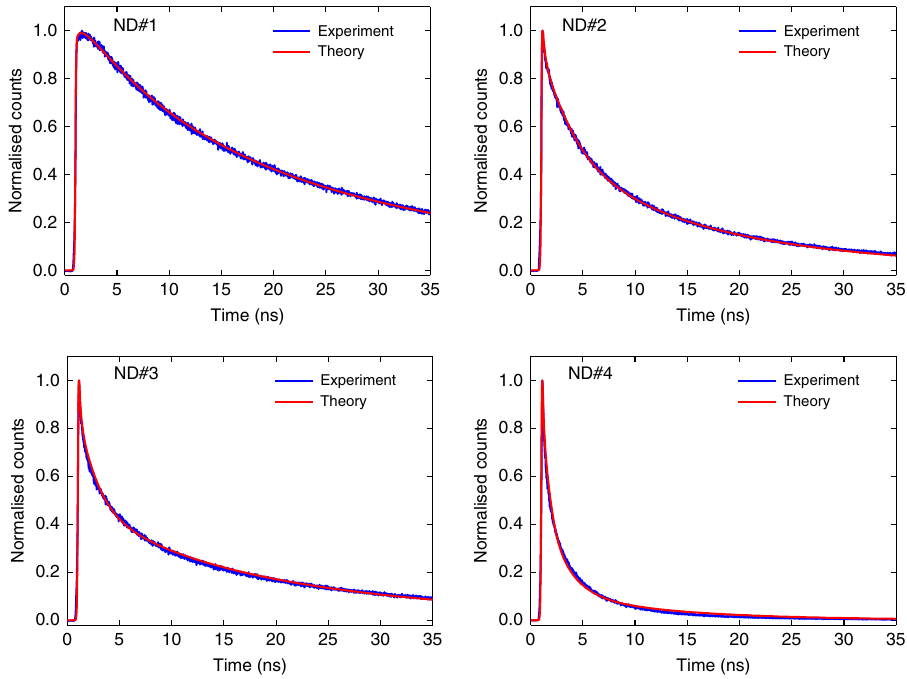
Fig. 2 Fluorescence decay curves and corresponding fi ts for four different NDs. The four graphs display measured fl uorescence decay curves (blue) with corresponding fi ts (red) obtained from our model (see main text), showing excellent agreement. Note that the curves are normalised to their respective maximum. The different NDs exhibit increasingly faster photo-emission, with corresponding lifetimes of {25, 3.6, 2.2, 1.1} ns for ND#1 – 4. The shorter lifetimes correspond to larger collective domain sizes of N max = {2, 7, 10, 50}, respectively (Supplementary Note